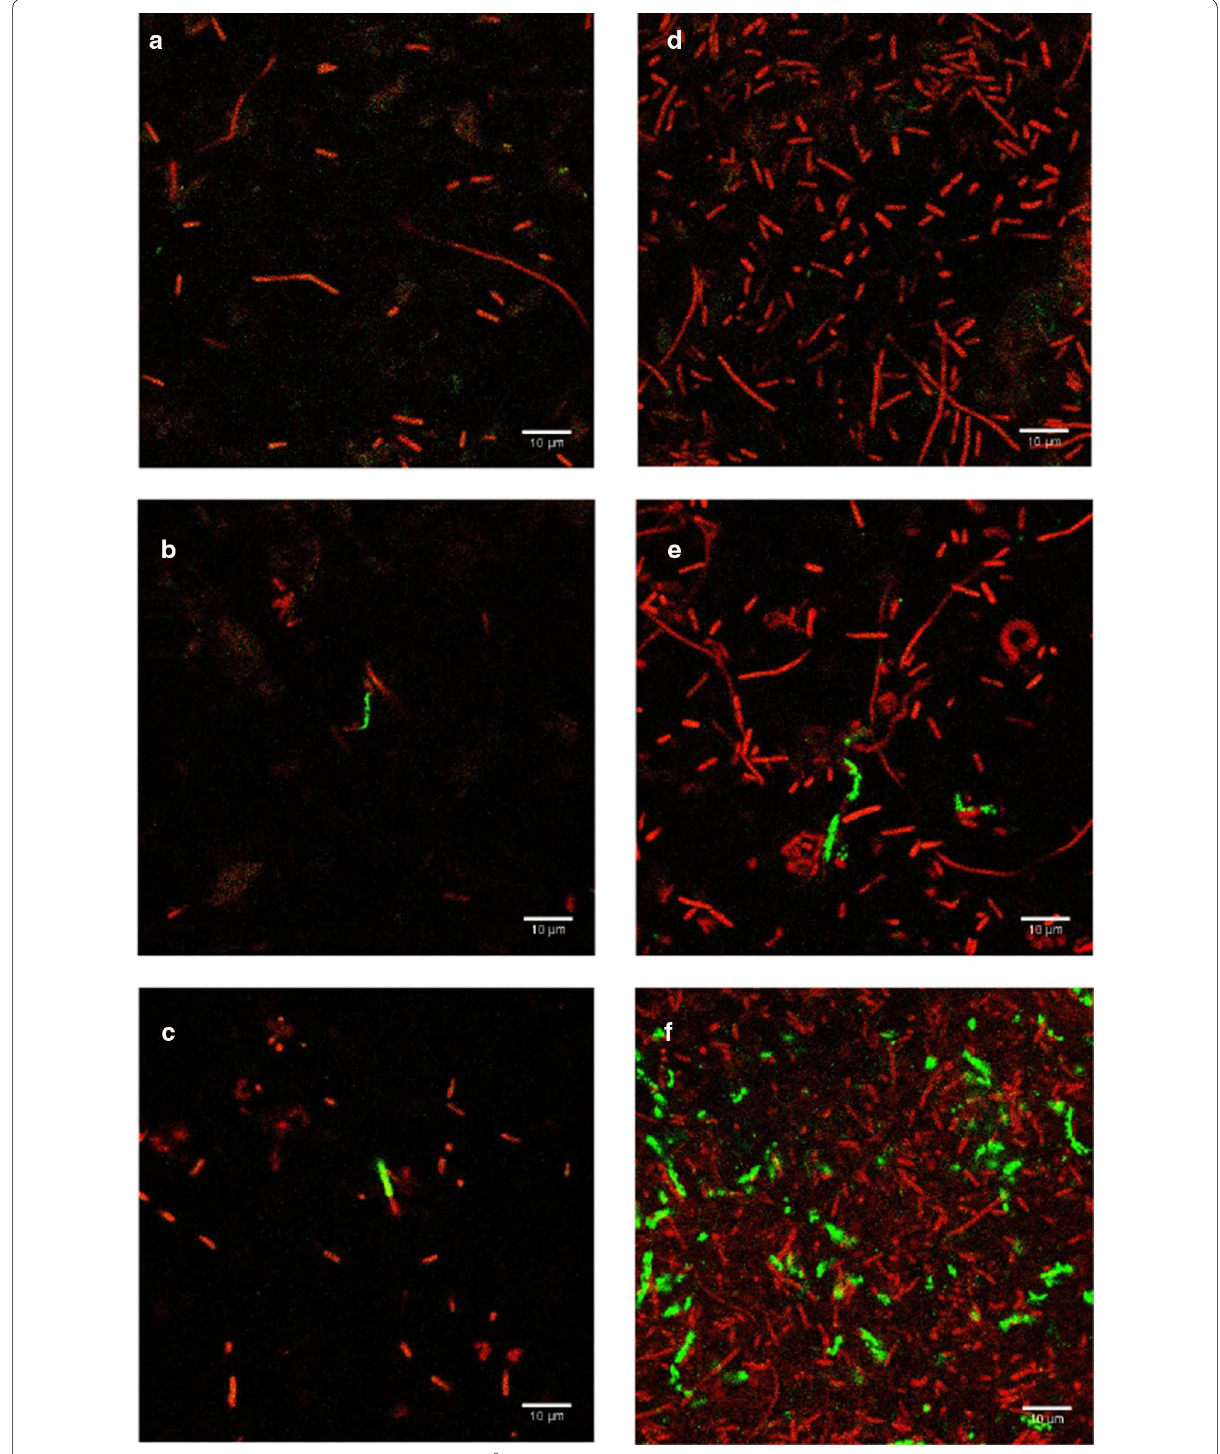
Fig. 2 Representative fluorescent images of E. coli BL21 10 2 CFU/ml after 4 h enrichment in TSB: a no phage infection, b after 15 min of T7-ALP infection, c after 30 min of T7-ALP infection. Fluorescent images of E. coli BL21 10 3 CFU/ml after 4 h enrichment in TSB: d no phage infection, e after 15 min of T7-ALP infection, f after 30 min of T7-ALP